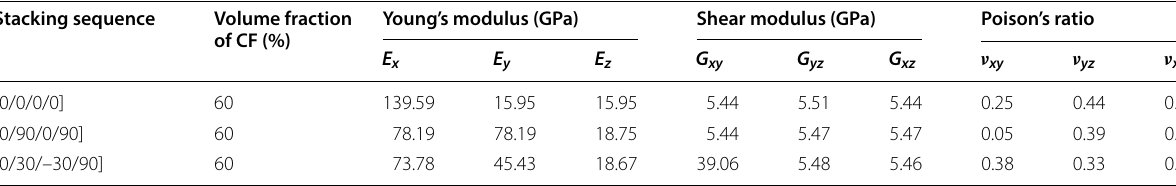
Table 3 Elastic properties of CF/epoxy laminated composite at 60% CF volume fraction Stacking